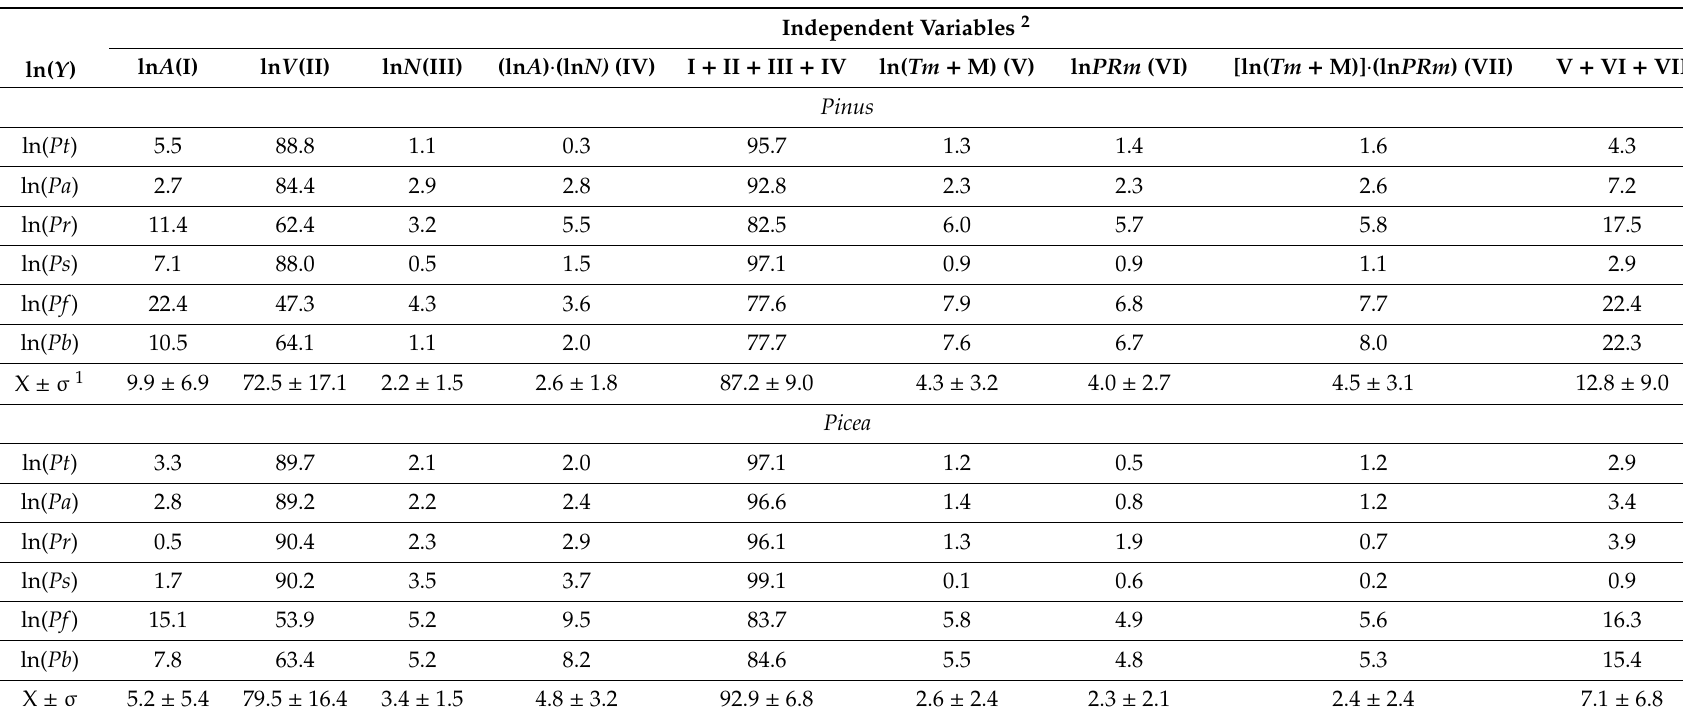
Table 2. Contribution of independent variables of Equation (1) to the explanation of the variability of dependent variables,